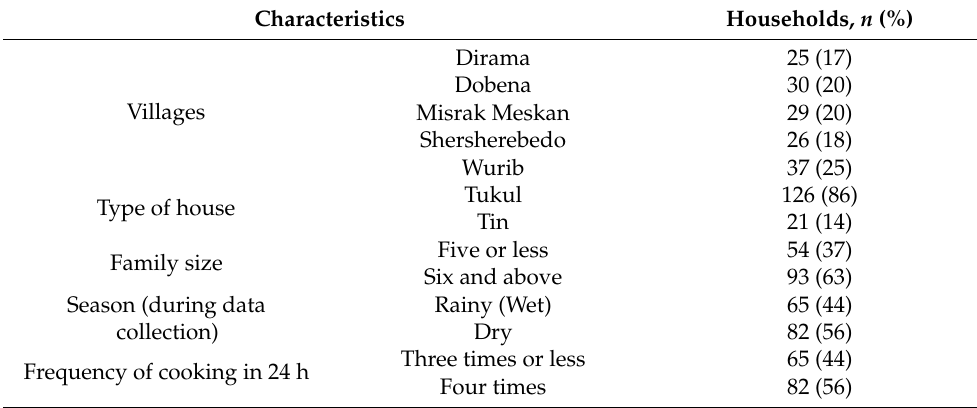
Table 1. Background characteristics and measurements of household particulate matter (PM 2.5